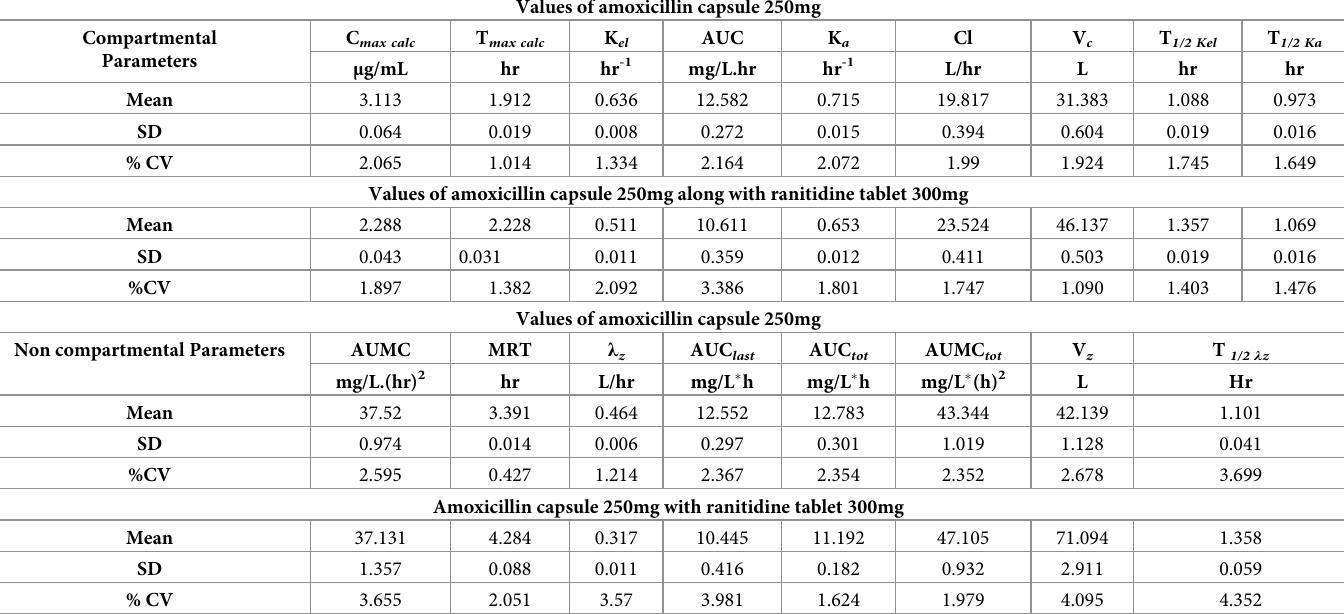
Table 2. Mean compartmental and non-compartmental pharmacokinetic parameters of amoxicillin 250 mg capsule after administration to healthy volunteers alone and in combination with ranitidine 300mg tablet. Values of amoxicillin capsule 250mg Compartmental Parameters